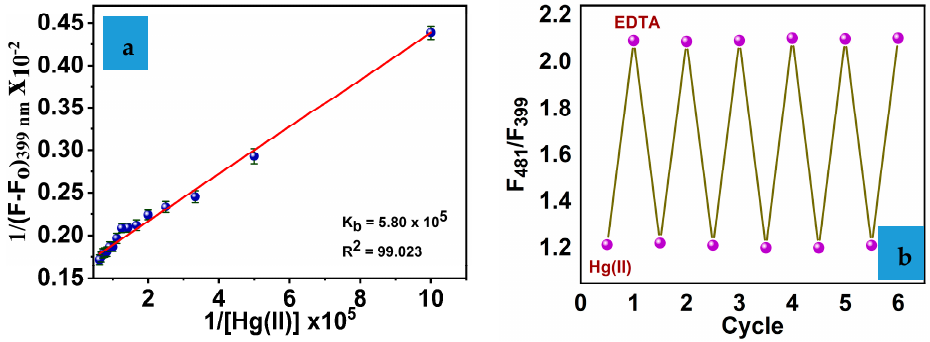
Figure 8. ( a ) Bensi–Hildebrand formulation based on (1/F–F o ) versus Hg(II) ( b ) The reversibility of IXZD optical sensor using EDTA at λ em = 481 nm.